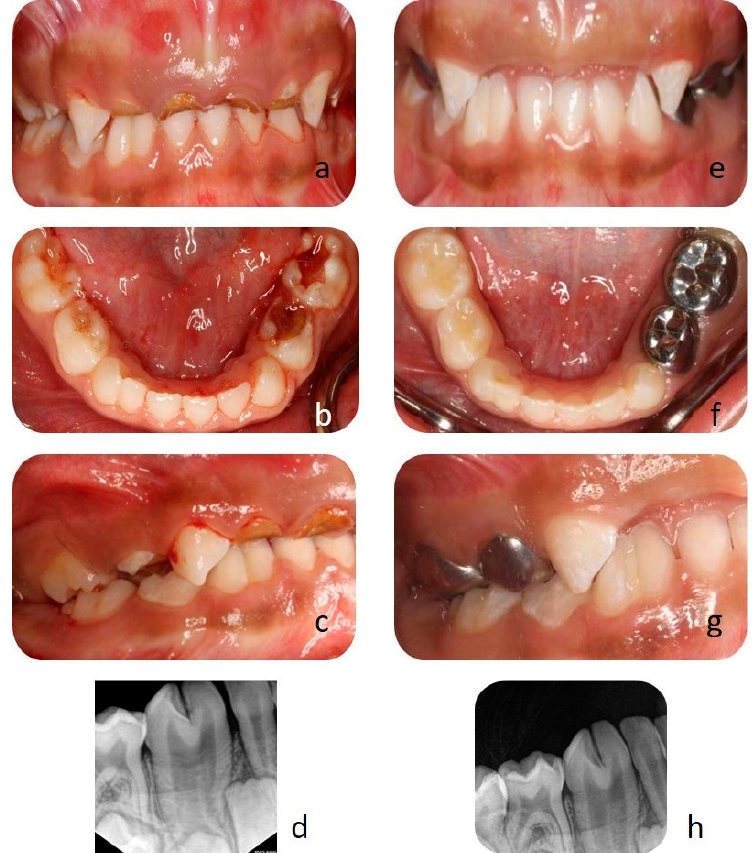
Figure 1. ( a , b ) Deep dental caries involving the pulp of primary upper central and lateral incisors and molars. ( c ) Fusion of canine and lateral incisors separated by a deep groove, ( d ) radiograph of fused teeth. ( e ) Post extraction. ( f , g ) Pulpotomy with stainless steel crowns, tooth-colored fillings on molars. ( h ) Fissure sealant between the groove of the fused tooth.